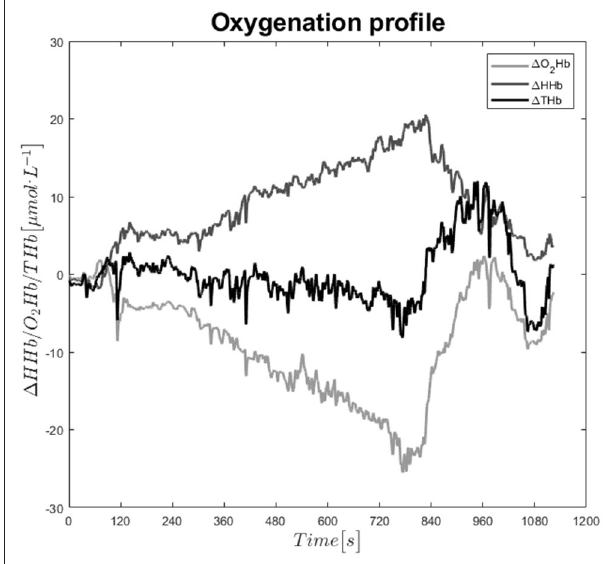
FIGURE 1 | Exemplary time-course of oxygenated, deoxygenated, and total hemoglobin during the CPET.